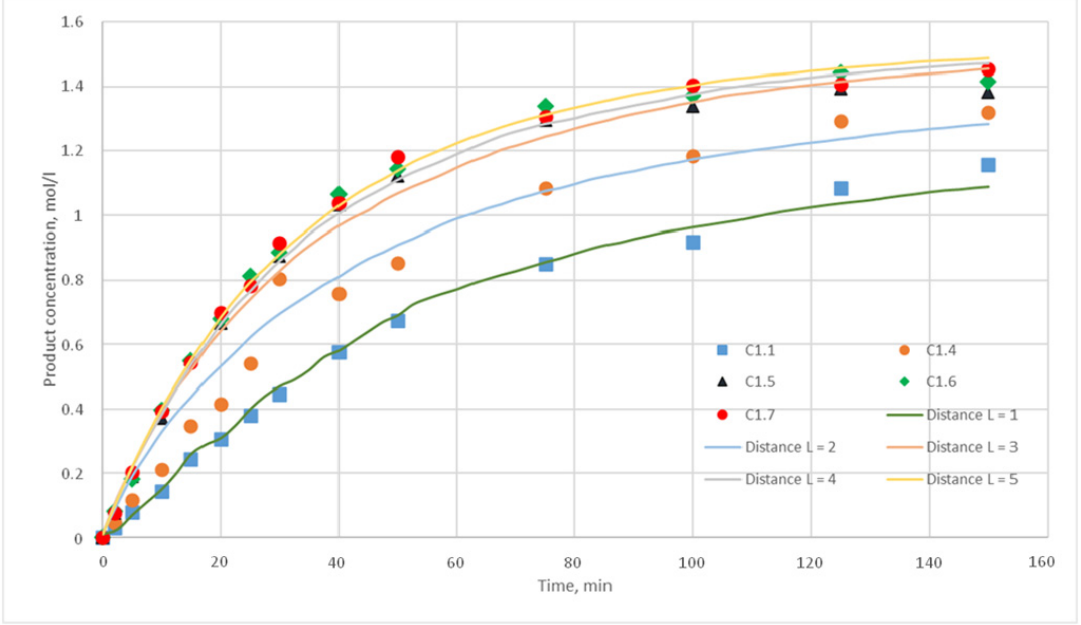
Figure 12. Calculation and experimental reaction kinetic curves. Reaction probability p = 0.020. Lines—calculation curves, points—experimental data.